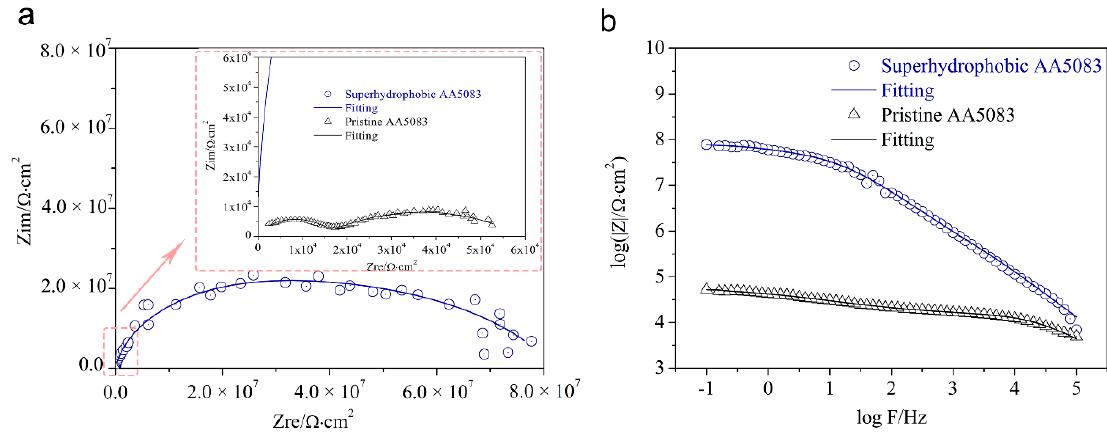
Figure 7. ( a ) Electrochemical impedance spectroscopy (EIS) plots, and ( b ) Bode plots of log | Z | vs. frequency and fittings of the pristine AA5083 and superhydrophobic AA5083 surfaces.